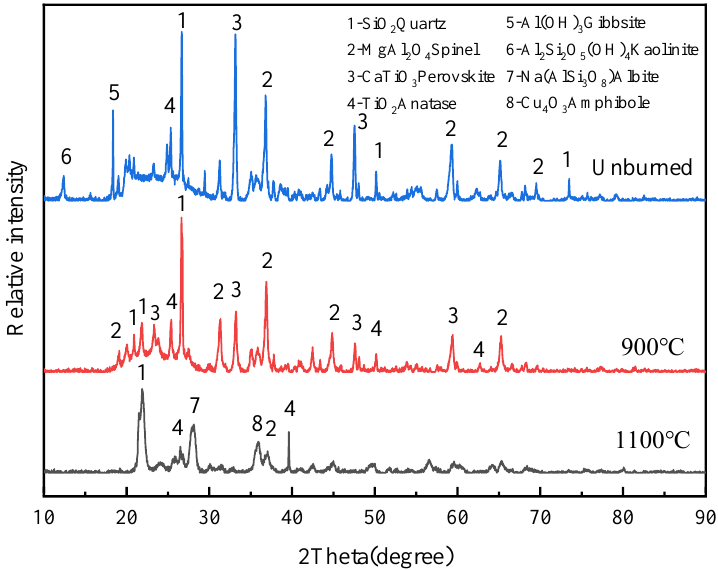
Figure 10. XRD spectrum of sintered bricks at different temperatures. Figure 11 demonstrates the SEM micrographs of sintered bricks at different tempera- tures. Unburned brick particles of polyaluminum chloride slag are arranged in a disorderly fashion (Figure 11a) and are consolidated by physical action at this time. When the tem- perature reaches 900 ◦ C (Figure 11b), the sintered brick just reacts and the debris structure on the particles gradually disappears. When the temperature reaches 1100 ◦ C (Figure 11c), more molten-liquid phase is formed in the structure to make the particles more closely connected, which improves the compactness of the sintered brick, thus improving the performance of the sintered